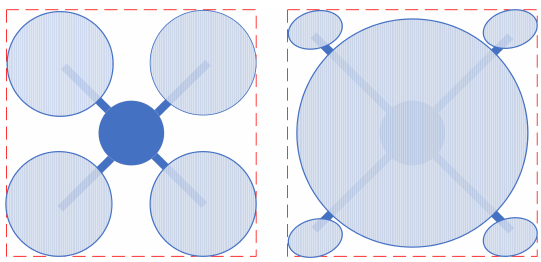
Figure 2. Comparison of the rotor disc area under a given footprint for a conventional quadrotor and heterogeneous multirotor